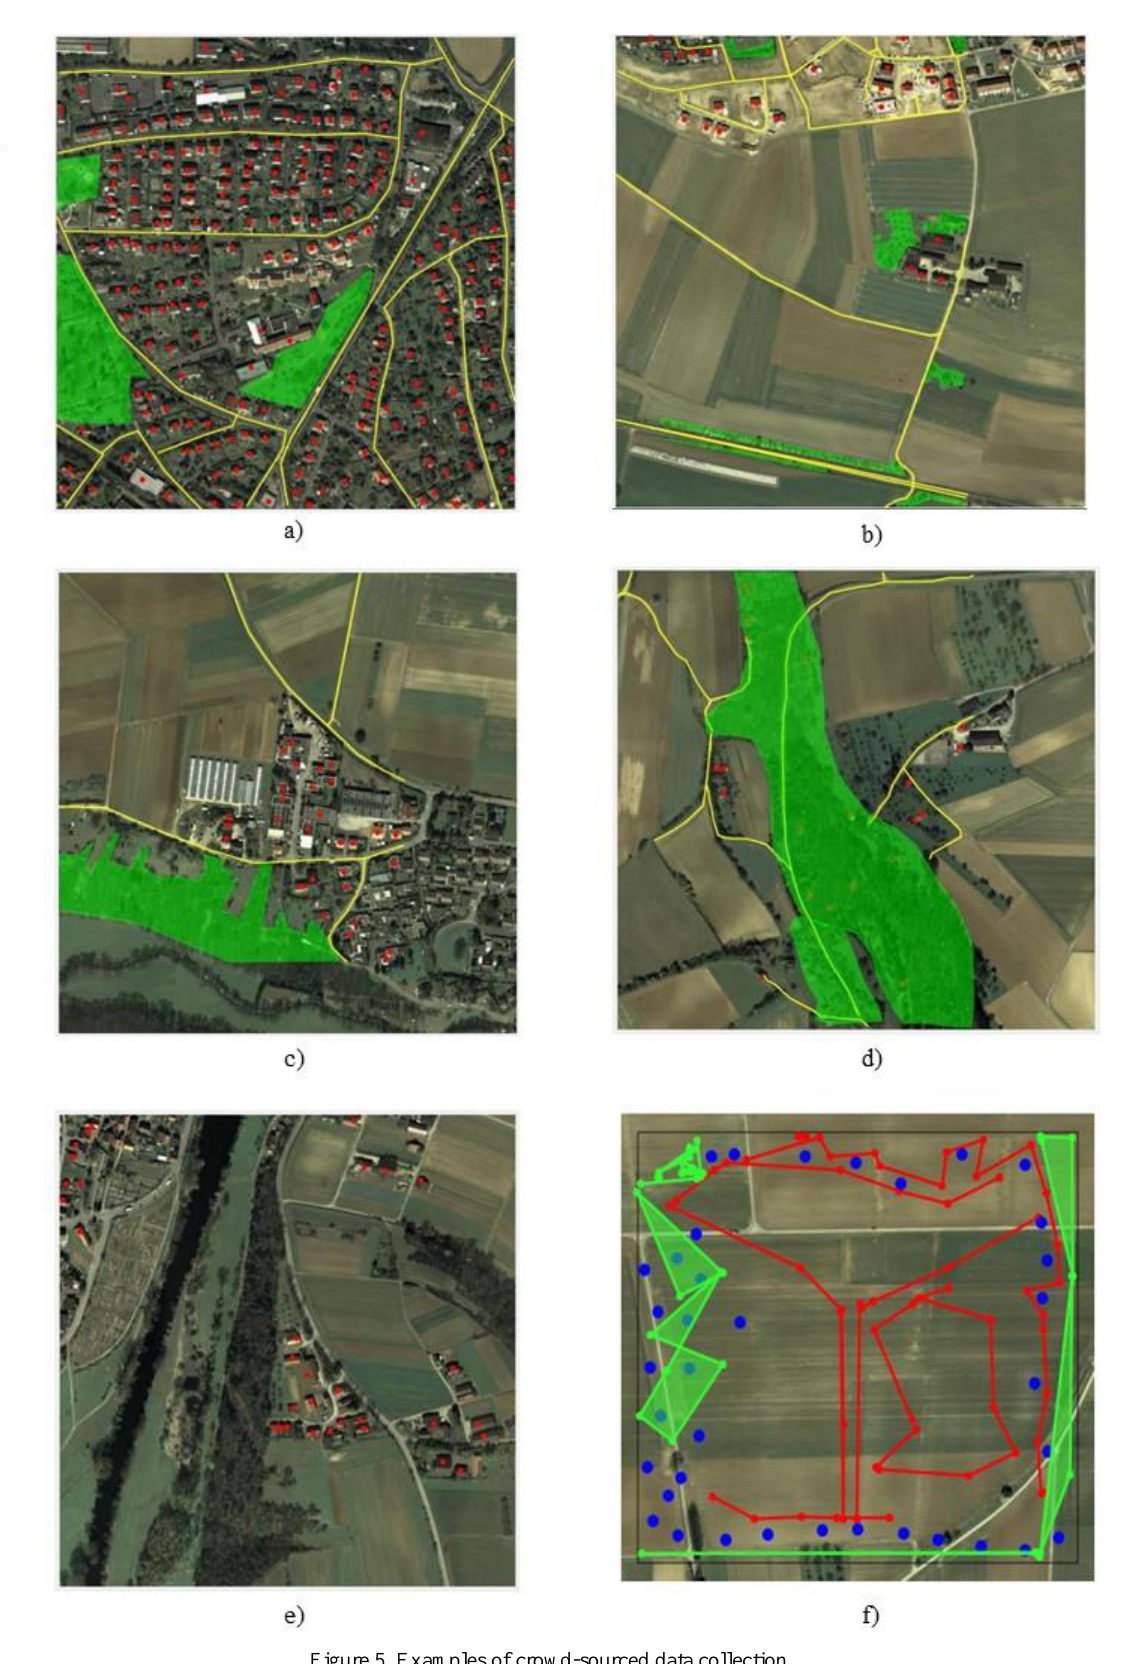
Figure 5. Examples of crowd-sourced data